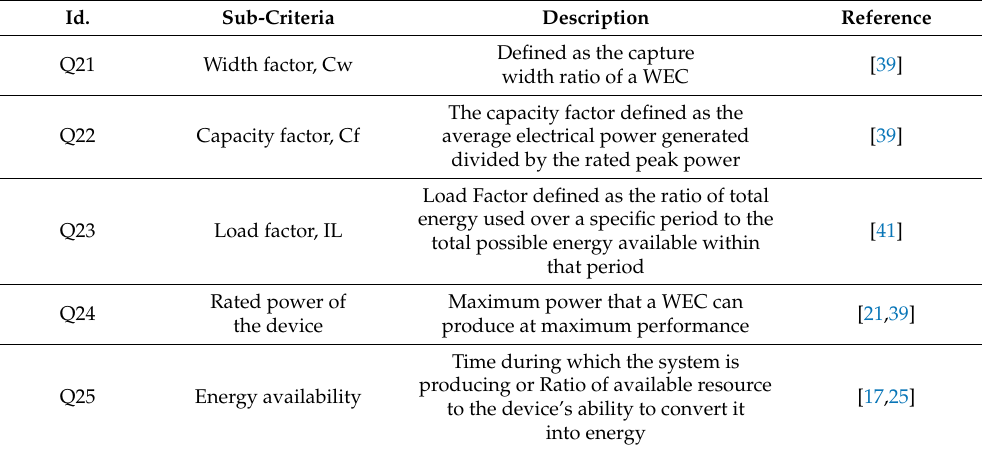
Table A6. Block 5: Influence of the efficiency of the generation system. Q21 to Q25. Id.